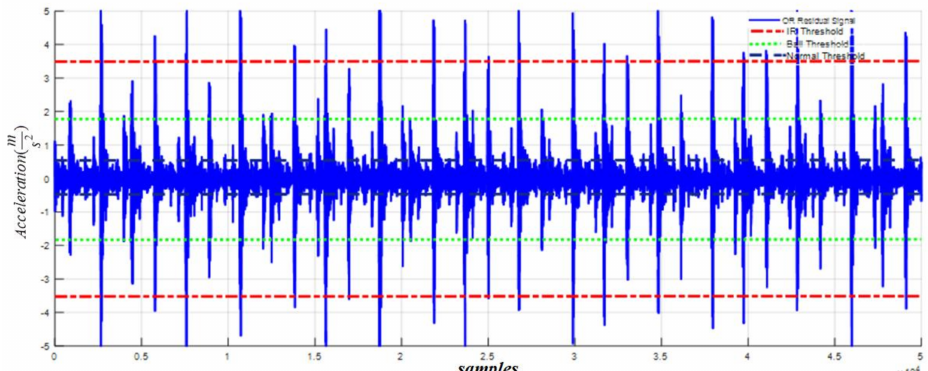
Figure 12. Residual of acceleration for outer fault signal: normal threshold ( ± 0.5), ball fault threshold ( ± 1.8), and inner fault threshold ( ± 3.5) at a crack width of 0.007.